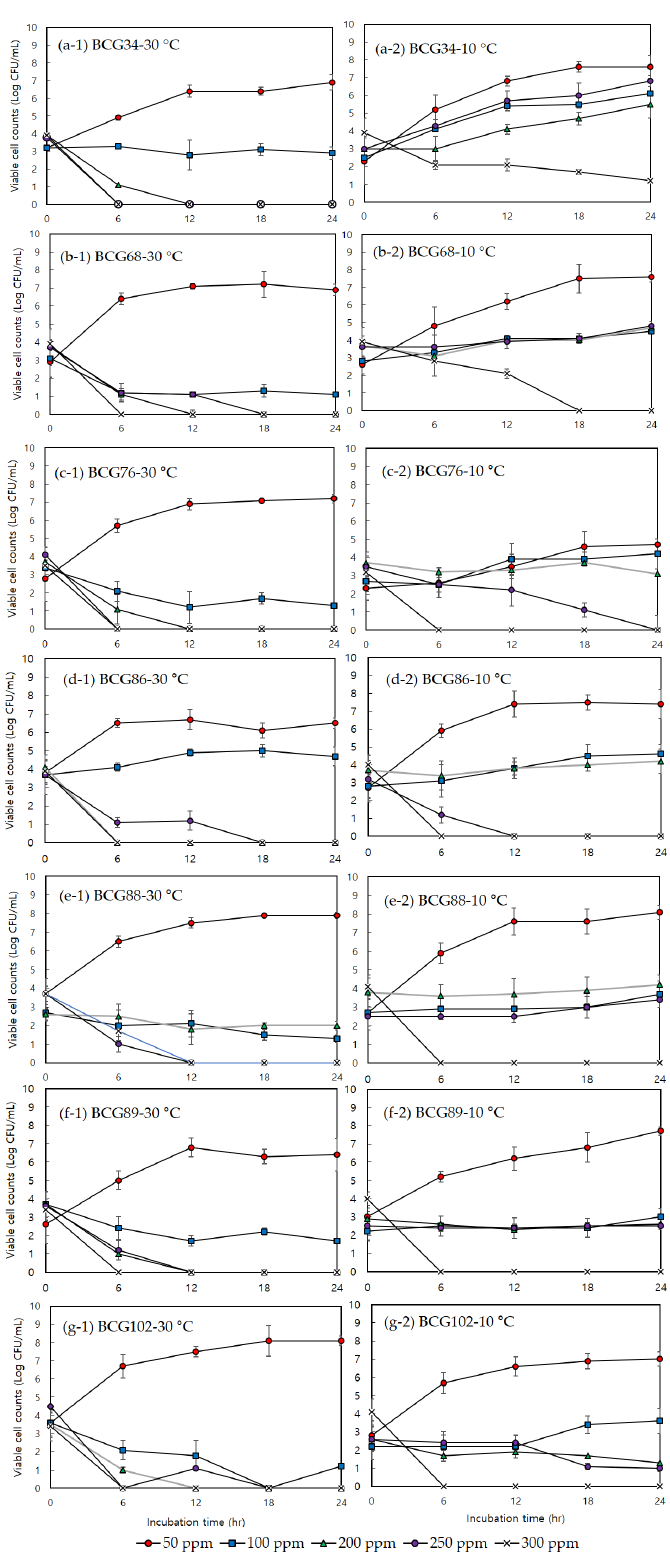
Figure 2. Growth curve experiments of seven psychrotolerant B. cereus group strains activated at 30 ◦ C ( a-1 , BCG34; b-1 , BCG68; c-1 , BCG76; d-1 , BCG86; e-1 , BCG88; f-1 , BCG89; g-1 , BCG102) and 10 ◦ C ( a-2 , BCG34; b-2 , BCG68; c-2 , BCG76; d-2 , BCG86; e-2 , BCG88; f-2 , BCG89; g-2 , BCG102) with different concentration (50, 100, 200, 250, and 300 ppm) of sodium hypochlorite during 24 hr. The error bars indicate standard deviation from triplicate